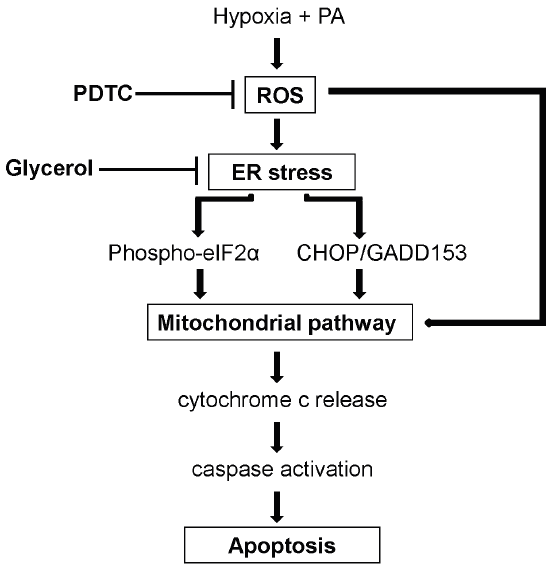
Figure 7. Proposed pathogenic model for the signal transduction pathway involved in hypoxia-aggravated